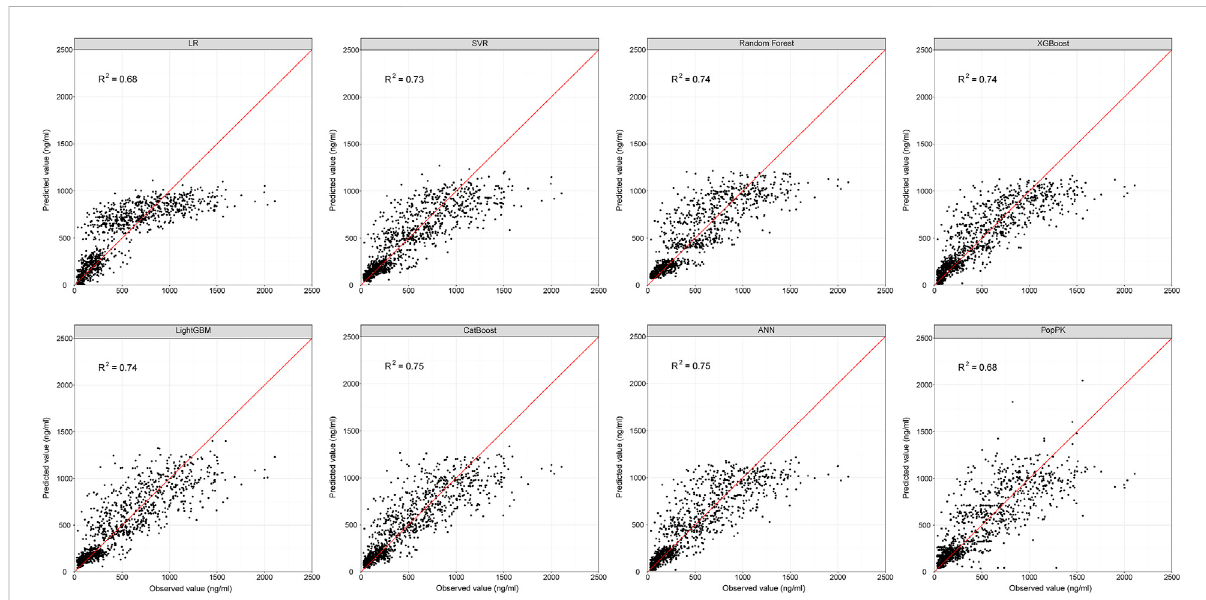
FIGURE 2 Scatterplots showingthereferenceand predictedcyclosporineconcentrationsfromtheevaluationdatasetfor MLandpopPKmodels.Redline represents the reference line. ANN, arti fi cial neural network; ML, machine learning; popPK, population pharmacokinetic model; R 2 , the squared correlation between the predicted and observed concentrations; LR, linear regression; SVR, support vector regression.